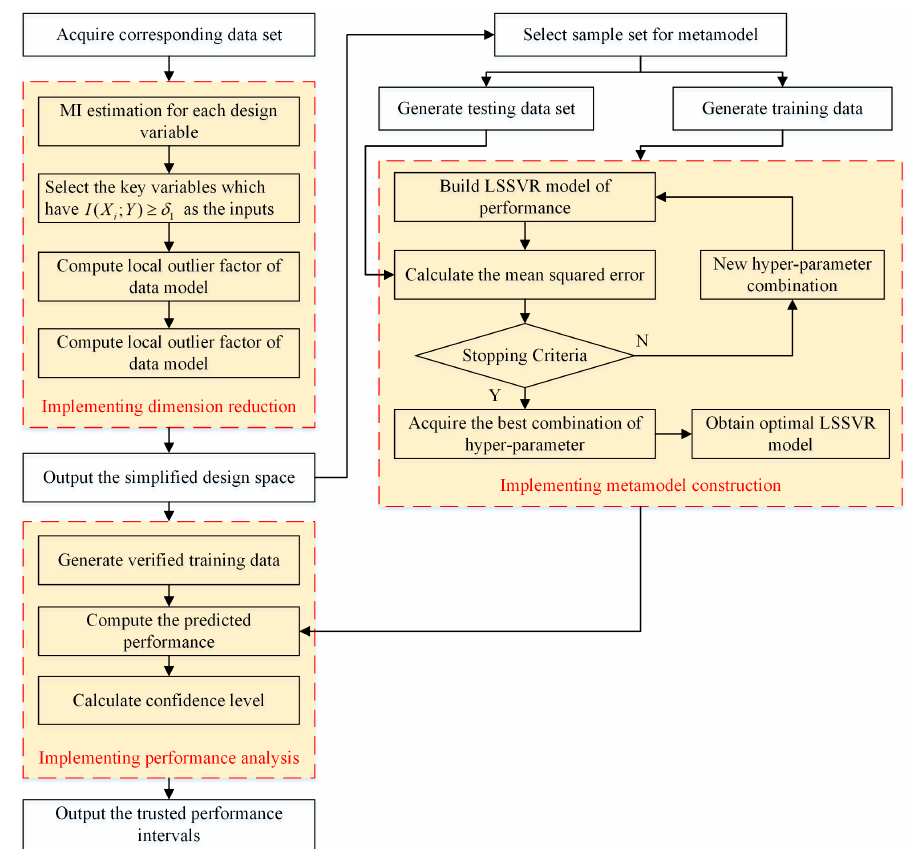
Figure 5. The flowchart of the proposed performance analysis approach.